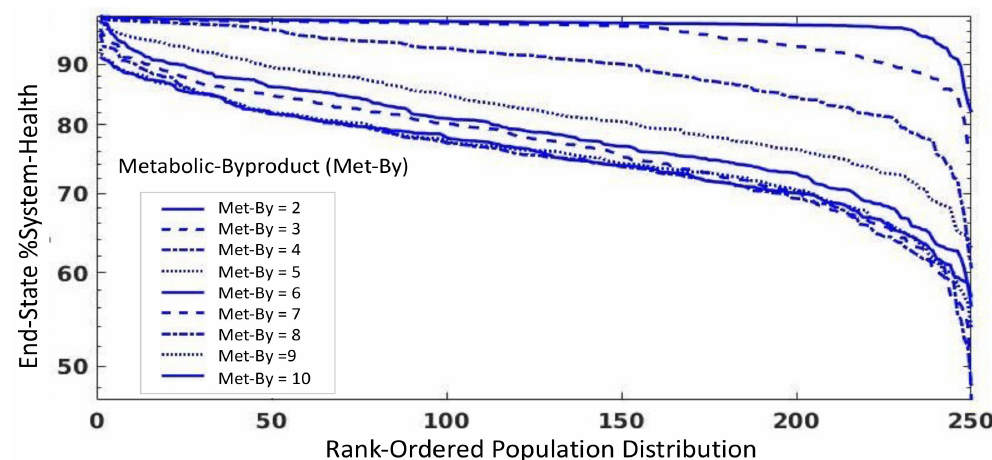
Figure 5. Parameter sweep of metabolic byproduct (Met-By), a proxy variable for stress in the CBIABM. All these simulations were carried out with an initial inoculum = 150 and run for 14 days of simulated time. The value for Met-By in the baseline bat parameterization is itself a 10 × increase in the same term in the human parameterization, reflecting the increased metabolic stress from powered flight. Increasing Met-By demonstrates a progressive worsening of the population distribution of %System-Health, which we consider a pre-condition for increase viral shedding. Interestingly, the decreasing %System-Health seen with increasing Met-By appears to converge